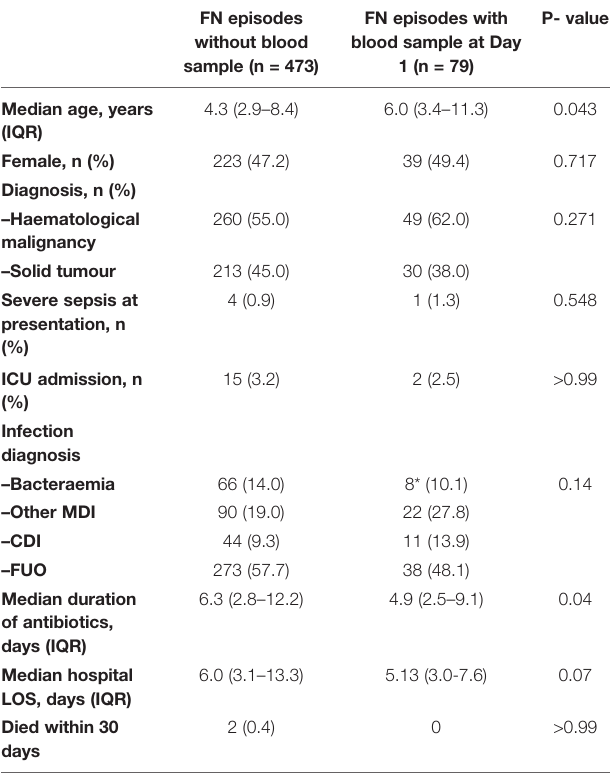
TABLE 2 | Demographic and outcome data of FN